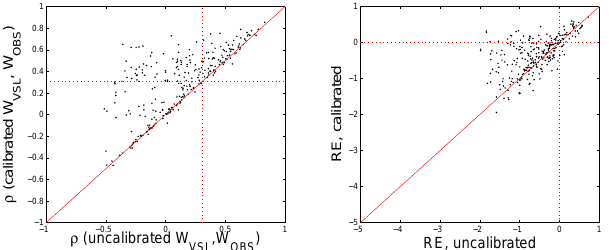
Fig. 7. Left: correlation of VS-Lite simulated ring width and ob- served ring width during the complement of the growth response parameter calibration interval for simulations run with posterior me- dian parameters and prior median parameters. Calibrated (uncali- brated) simulations at 160 (87) sites have positive significant cor- relations with observations at p < 0 . 05. Right: RE statistic for VS- Lite simulations in the complement of the growth response parame- ter calibration interval ring-width index using posterior median pa- rameters and prior median parameters. RE is greater than zero and thus indicates skillful simulations at 74 (44) of calibrated (uncali- brated)